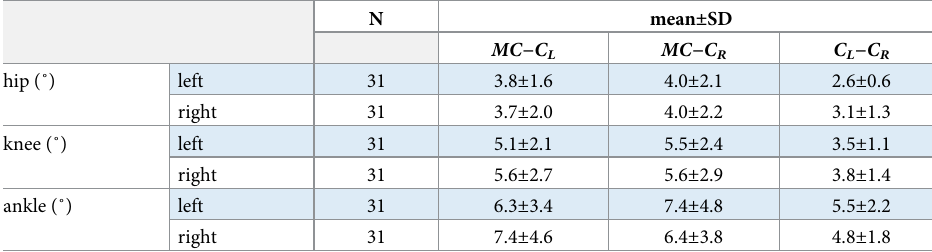
Table 6. Mean absolute error comparisons of joint angles. MC : motion capture; C L : OpenPose left-side view; C R : OpenPose right-side